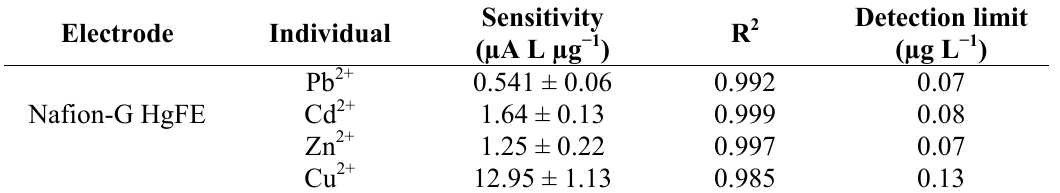
Table 1. Sensitivity values, correlation coefficients (R 2 ) and detection limits for Zn 2+ , Cd 2+ , Pb 2+ and Cu 2+ determined individually on a Nafion-G mercury film electrode.